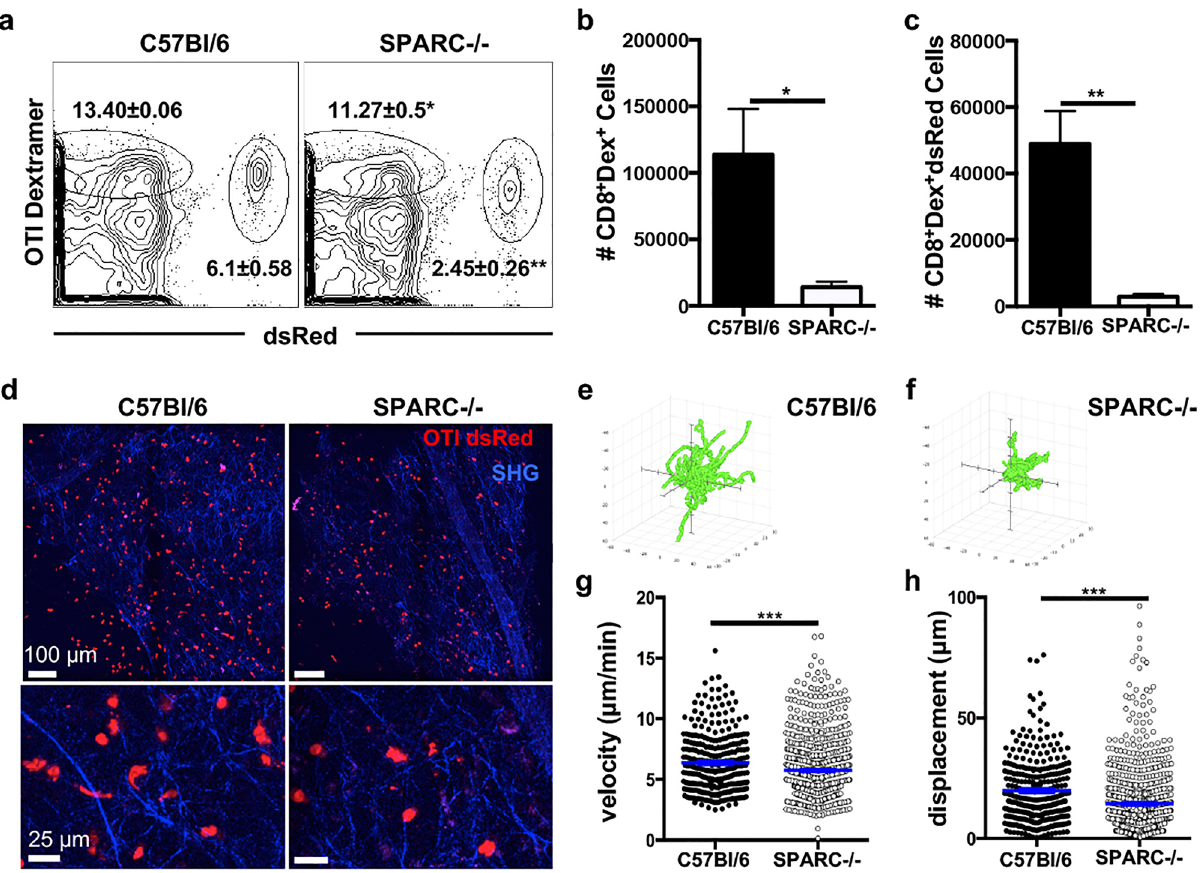
Figure 7. SPARC facilitates optimal CD8 + T cell migration in the brain. C57Bl/6 and SPARC−/− mice were infected with Pru-OVA for 21 days before receiving 5 × 10 6 OVA specific dsRed + CD8 + T cells. Analyses were conducted one week post transfer. (a) Flow cytometry plots of endogenous (left gate) and transferred OVA specific dsRed T cells (right gate) isolated from the whole brain of chronically infected C57Bl/6 and SPARC−/− mice. ( b ) Absolute cell numbers of endogenous OVA specific T cells calculated from the frequencies presented in ( a ). ( c ) Absolute cell numbers of transferred dsRed + OVA-specific T cells calculated from the frequencies presented in a. ( d ) 2 × 2 tiled images were taken of the cortex using two-photon microscopy to visualize the distribution of T cells infiltrating the brain ( e–h ) Videos imaged of cell migration in the infected brain were analyzed. Flower plots of cell tracks from C57Bl/6 ( e ) and SPARC−/− ( f ) normalized to the origin. Velocity ( g ) and displacement ( h ) for cells recruited to C57Bl/6 brains compared to cells migrating in SPARC−/− brains were quantified. Cells were tracked using Volocity software and migration data was analyzed using the Mann– Whitney test, *** p < 0.001. Flow cytometry data was analyzed using the student’s T test, * p < 0.05, ** p < 0.01. Data are representative of at least 2 individual experiments with a minimum of n = 3 and are represented as mean ±